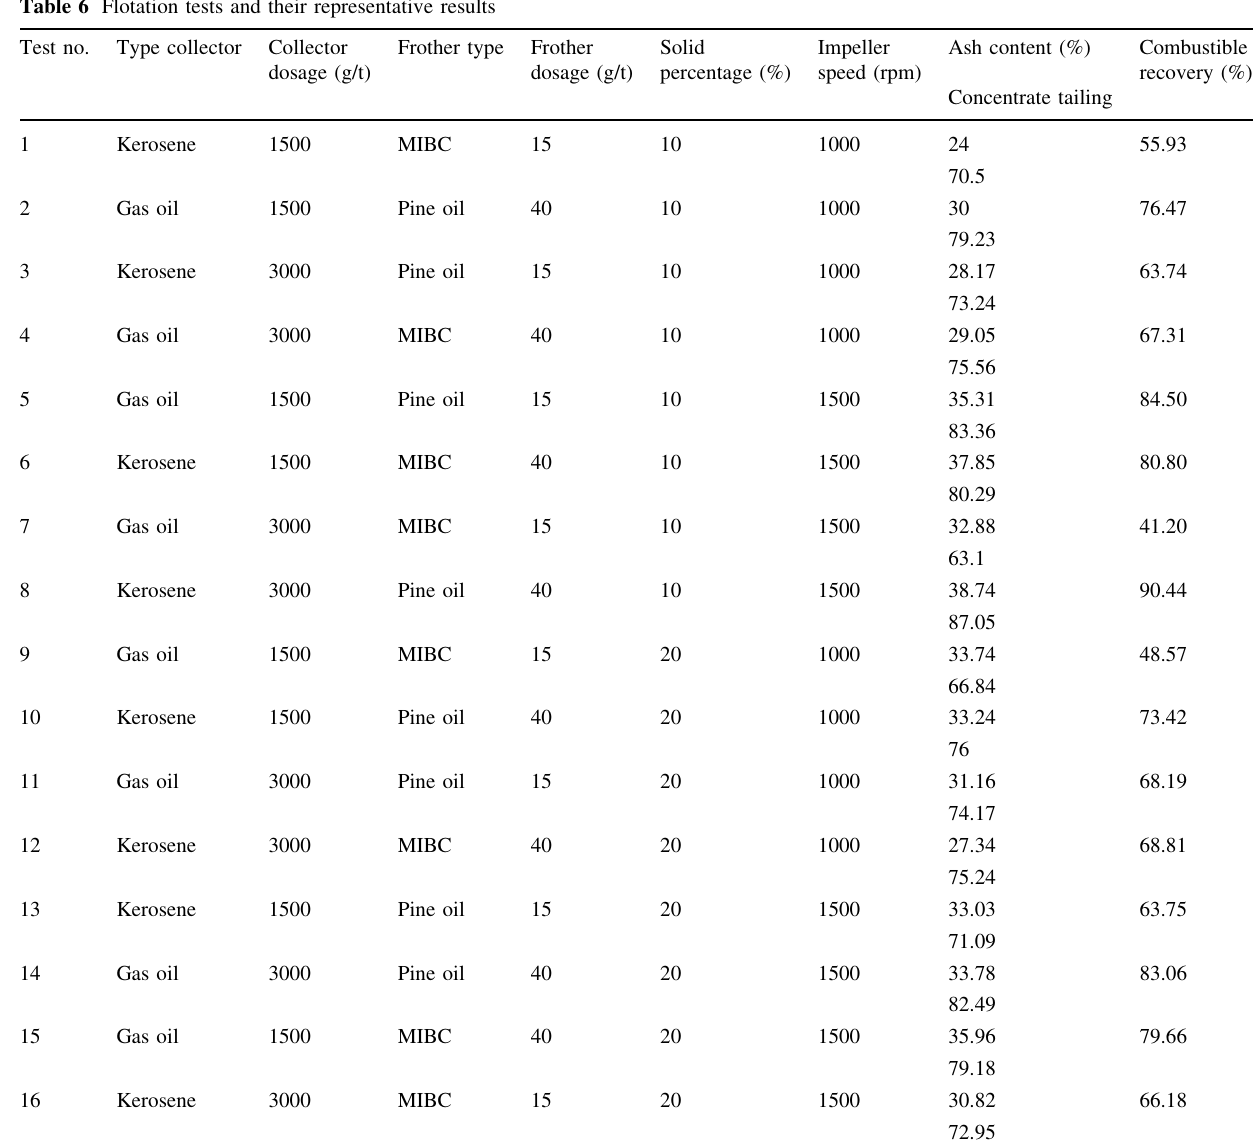
Table 6 Flotation tests and their representative results Test